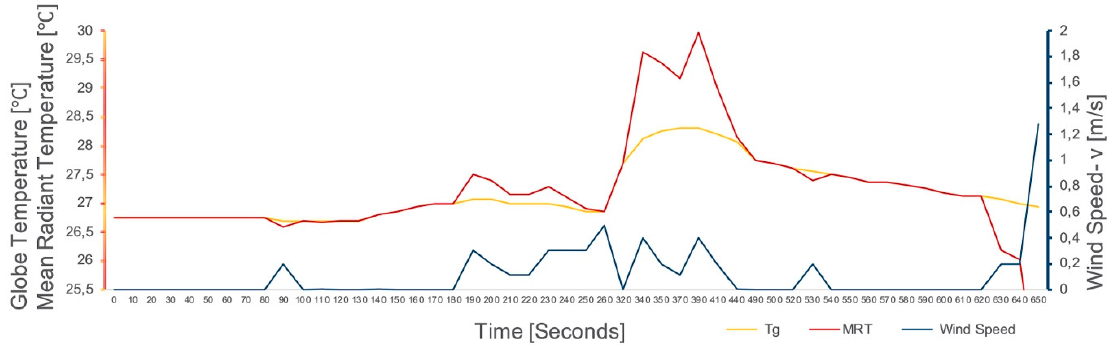
Figure 7. Globe temperature, wind speed, and mean radiant temperature curves.